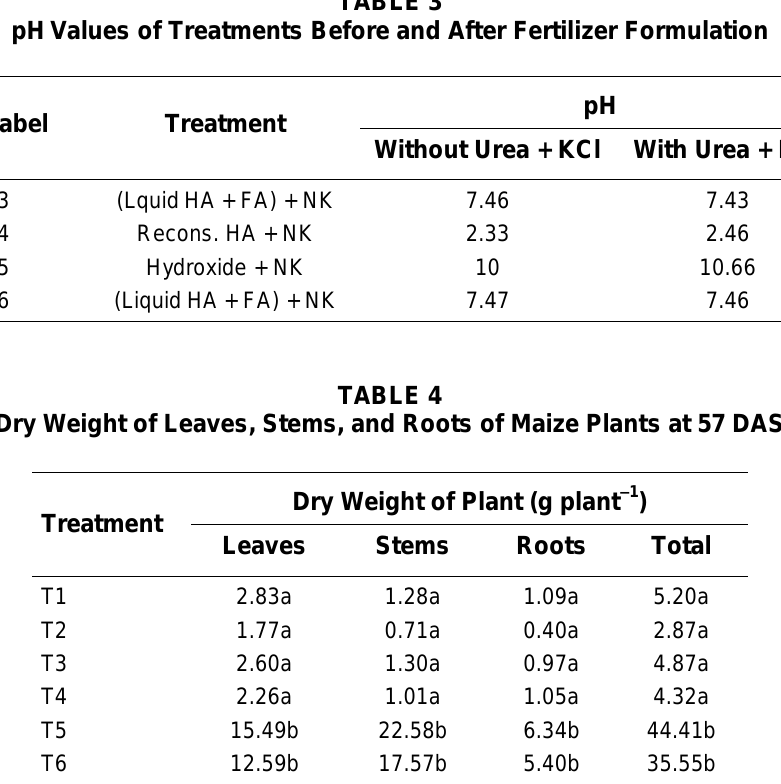
Different letters within a column indicate significant difference